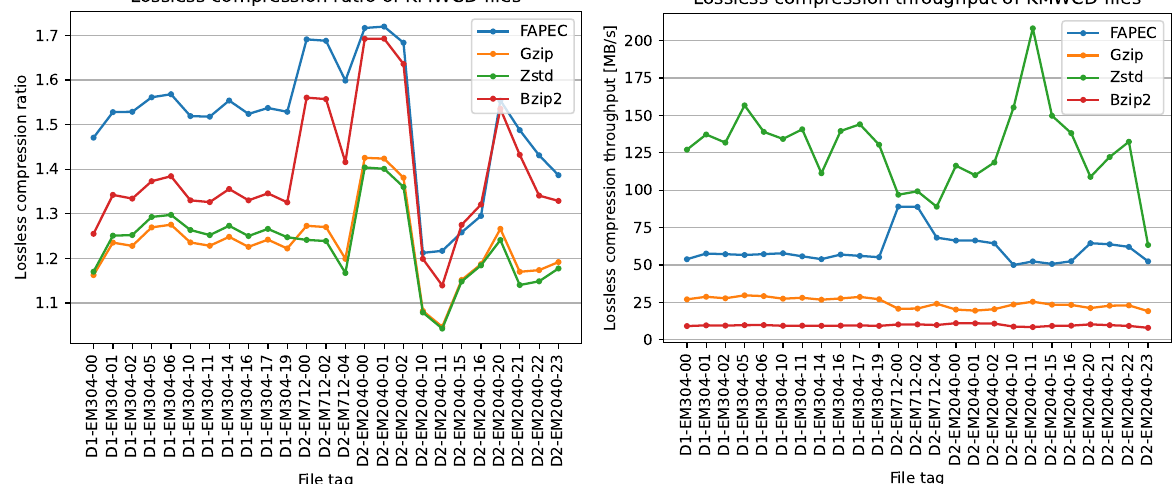
Figure 9. Lossless compression ratio ( left panel) and lossless compression throughput ( right panel) for the tested KMWCD